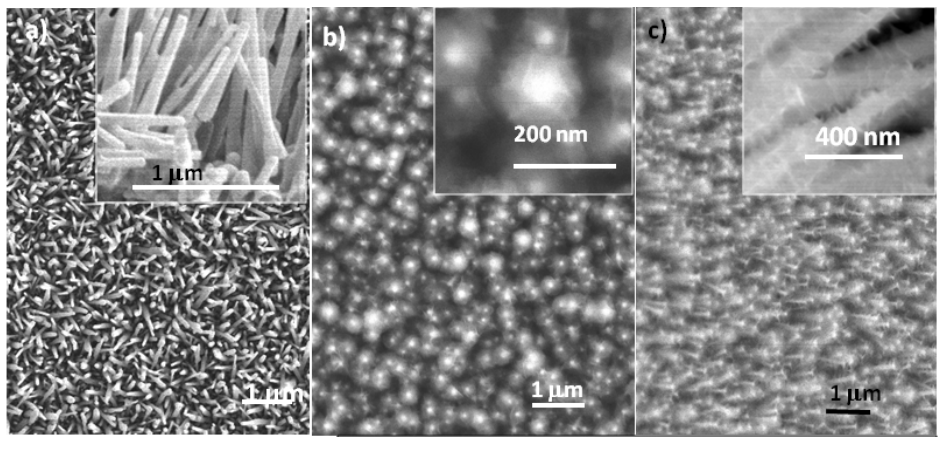
Figure 4. Solution processed ZnMgO nanorods using sequential hydrothermal synthesis: ( a ) top view of as-prepared ZnO nanorods, inset is the side view of ZnO nanowires; ( b ) top view of ZnMgO nanorods after 2-step hydrothermal synthesis; and ( c ) side view of ZnMgO nanorods; ( d ) ZnMgO nanorods after a 900 °C ambient annealing for 5 min; and ( e )